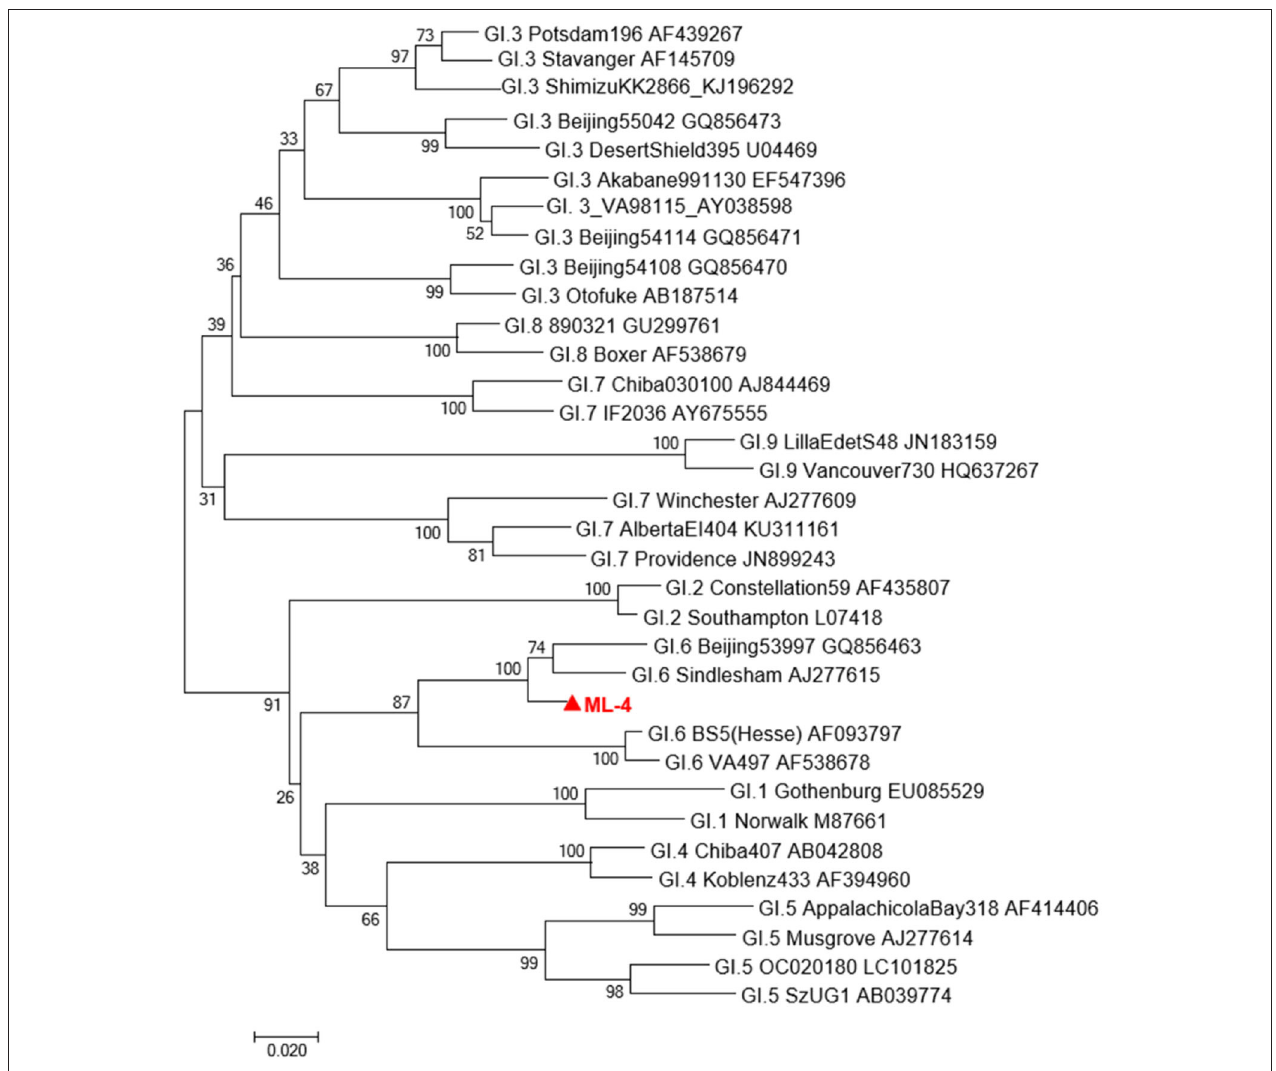
FIGURE 1 | A phylogenetic tree of GI type sequence in Oyster isolates in Yantai city and representative GI strains of other genotypes. Virus strains indicated by are from